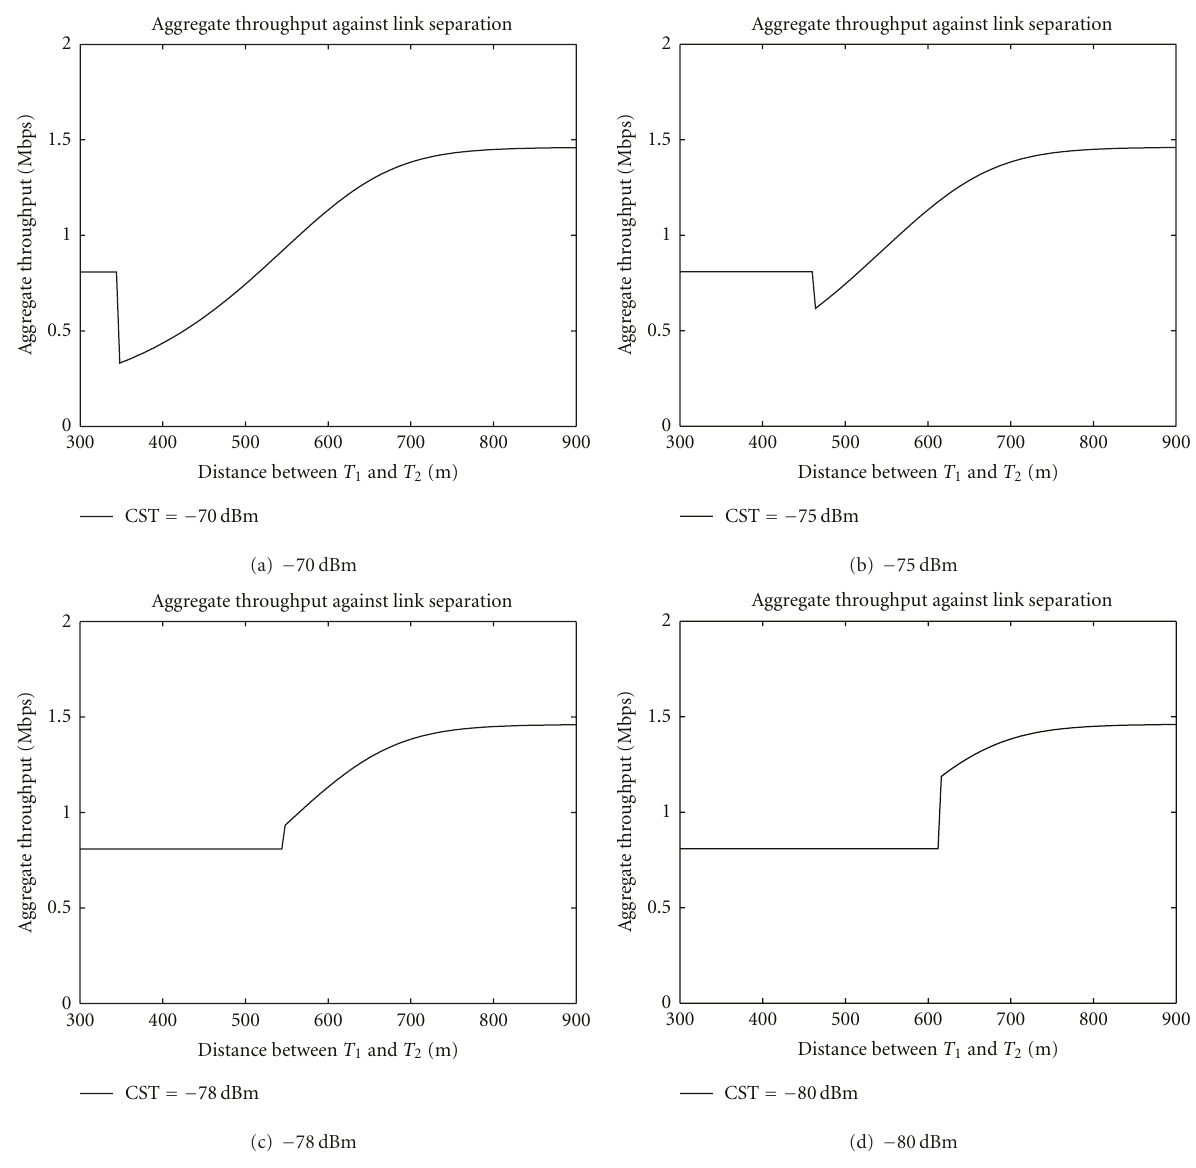
Figure 6: Aggregate throughput for the topology in Figure 5 with length of links = 450 meters and various carrier sensing